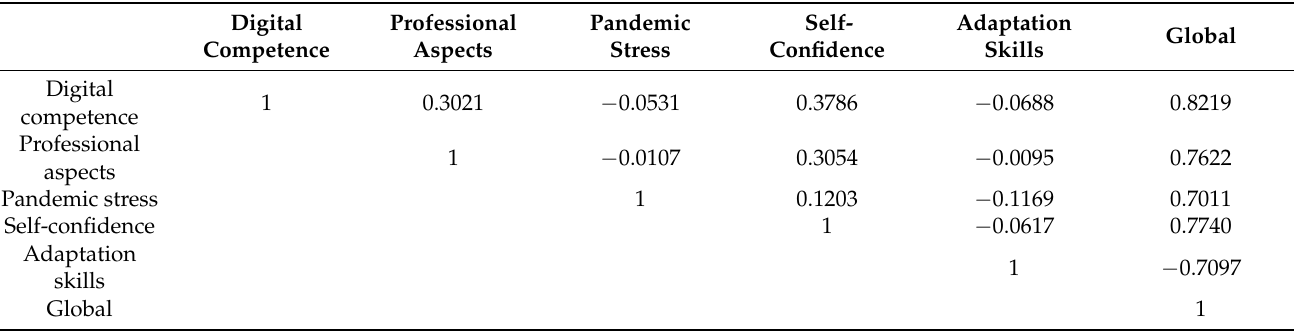
Table 5. Pearson correlation coefficients of the different subscales among themselves and with respect to the global